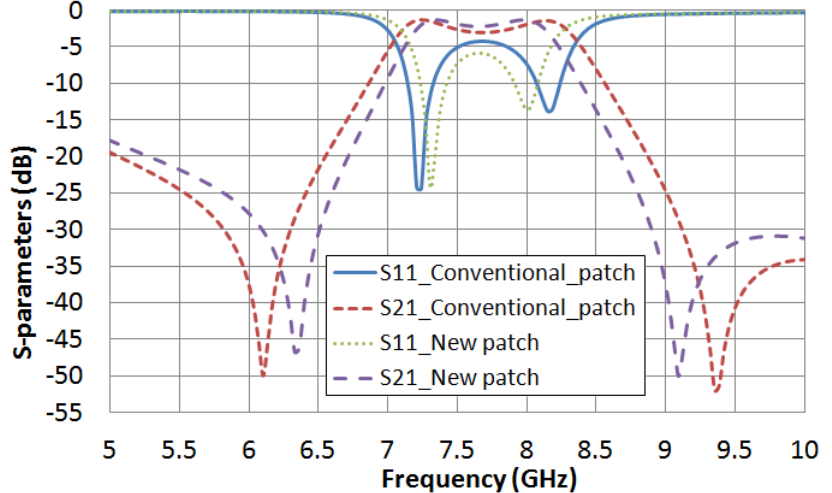
Figure 3. S-parameters obtained in simulation for both filters with a conventional dual-mode patch and with the new dual-mode one with a square